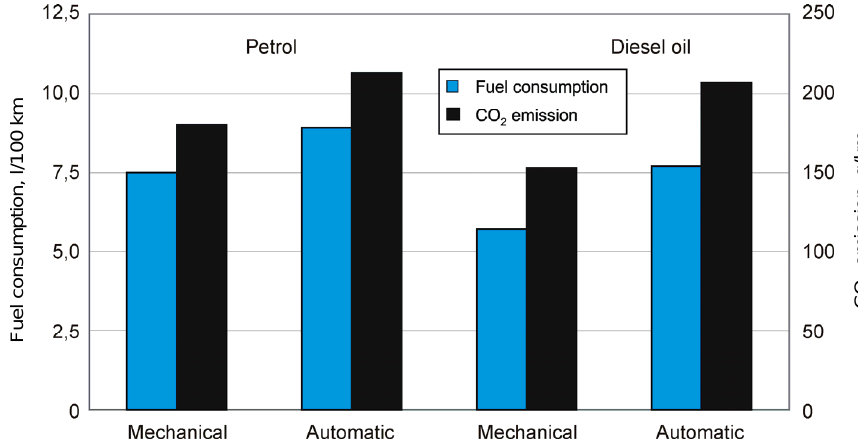
Fig 7. The relationship between average fuel consumption and CO 2 emission of an automobile and type of transmission used